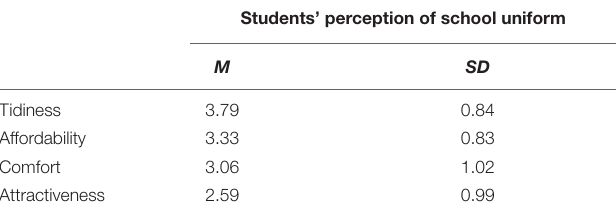
TABLE 2 | Means and standard deviations of students’ agreeableness to each